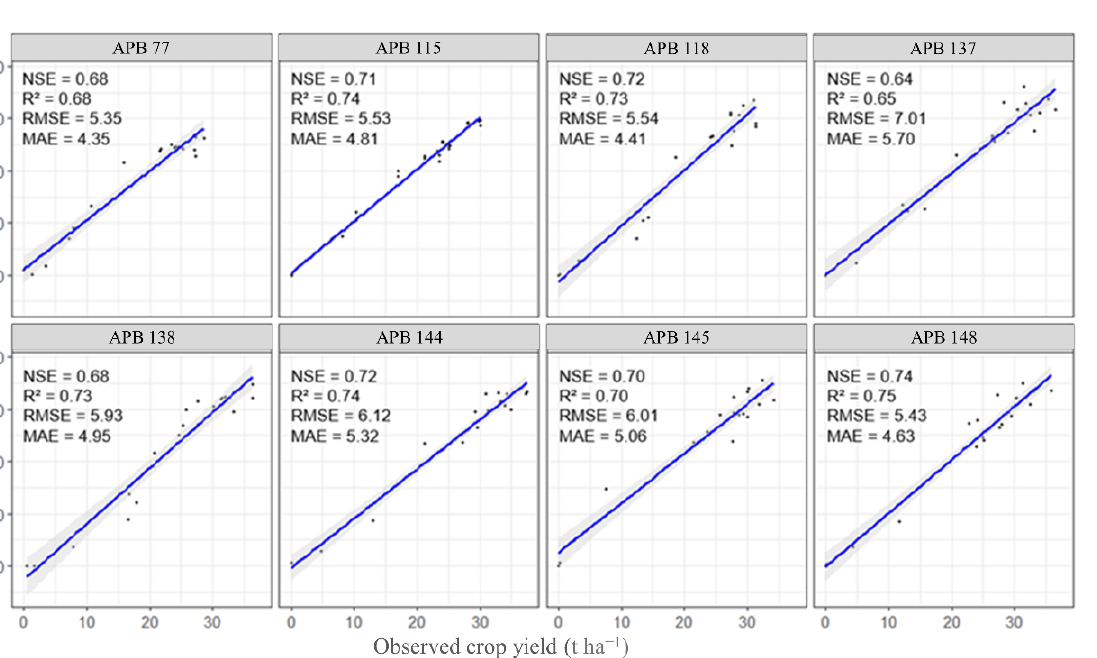
Figure 10. Observed versus simulated performance of APSIM models for each selected APBs for the period 1995 – 2015. The black dots are the data of crop yield (observed and simulated) for each selected APBs, the blue line is the best-fitting line between the data.